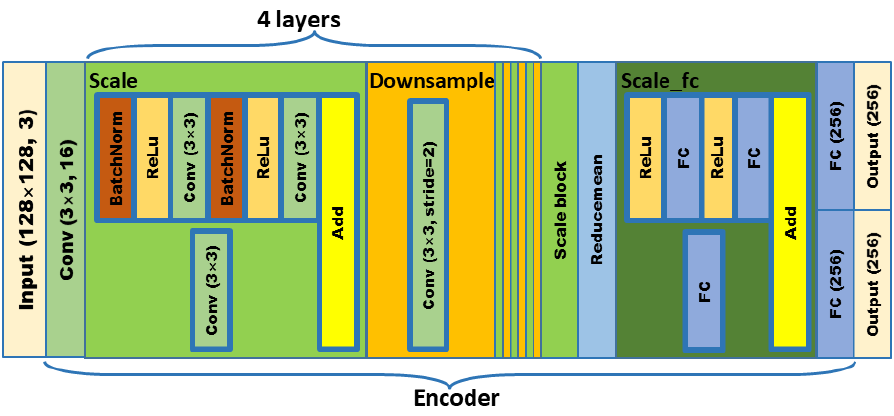
Figure 4. Encoder network.